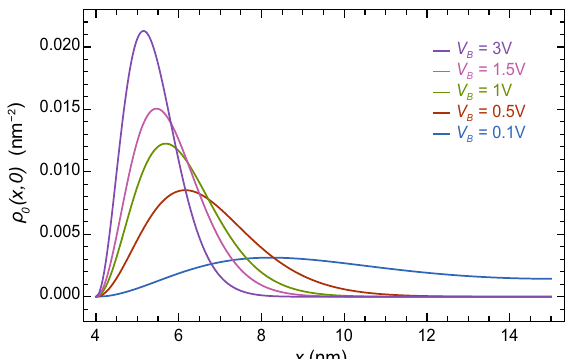
Figure 9. Ground-state two-dimensional electron density along the positive Ox axis for model 1 at bias voltages of 0.1 V, 0.5 V, 1 V, 1.5 V, and 3 V.